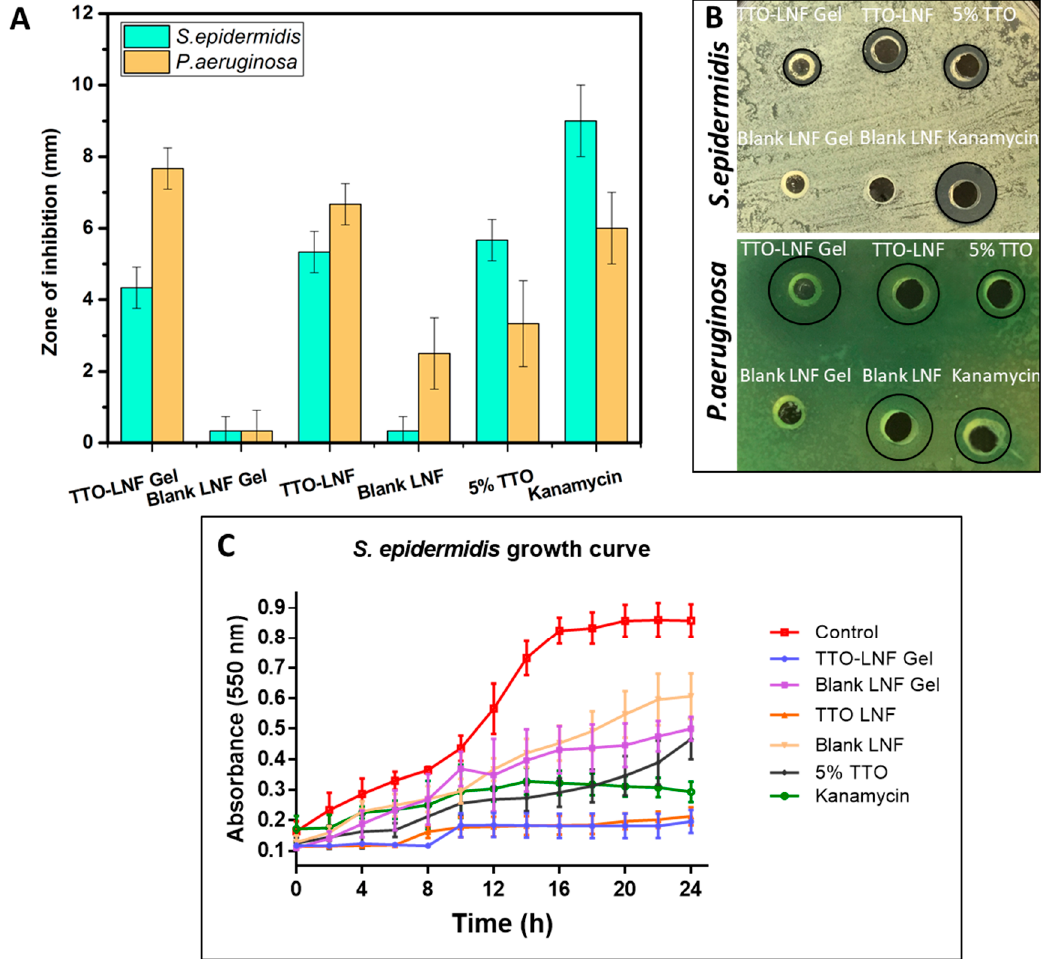
Figure 4. ( A ) S. epidermidis and P. aeruginosa zone of inhibition after treating with the different formulation and its corresponding representative digital photographs ( B ). ( C ) Time-dependent growth curve of S. epidermidis when treated with formulations in comparison to the untreated control.